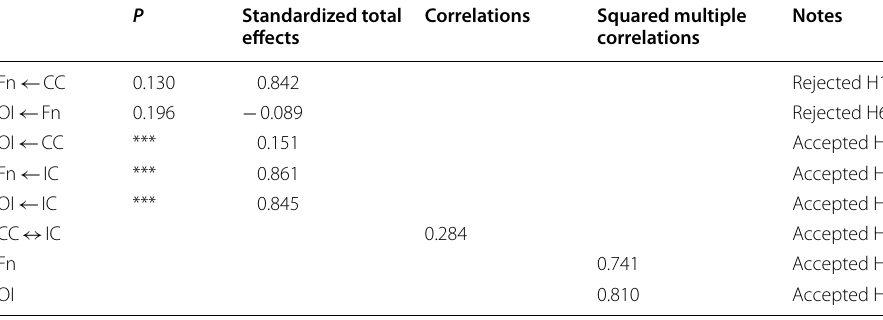
Table 8 Result of hypotheses